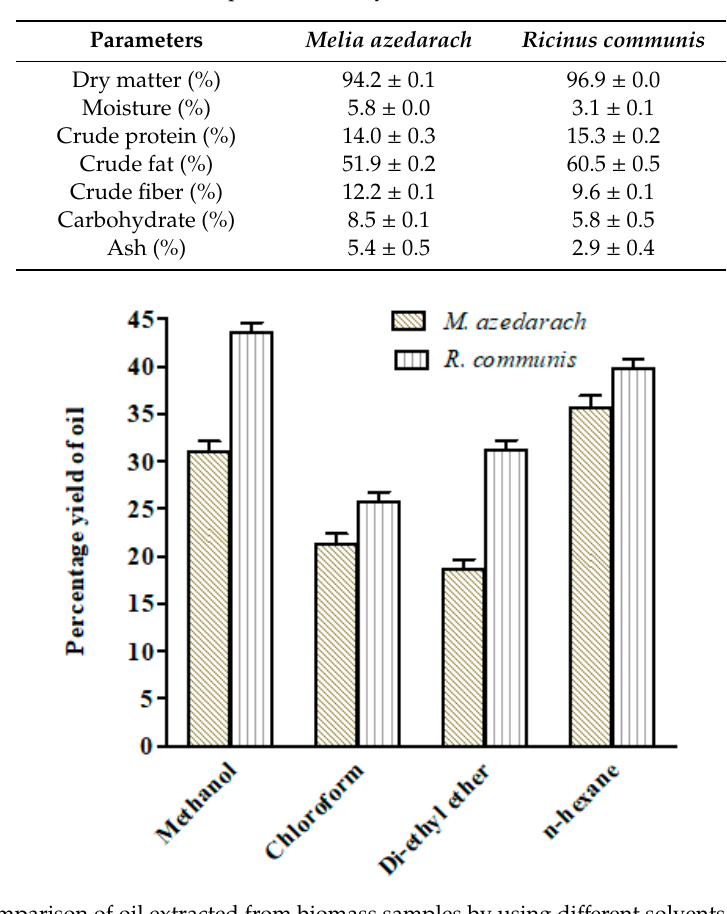
Figure 1. Comparison of oil extracted from biomass samples by using different solvents (Organized by Decreasing Polarity Index). Decreasing Polarity